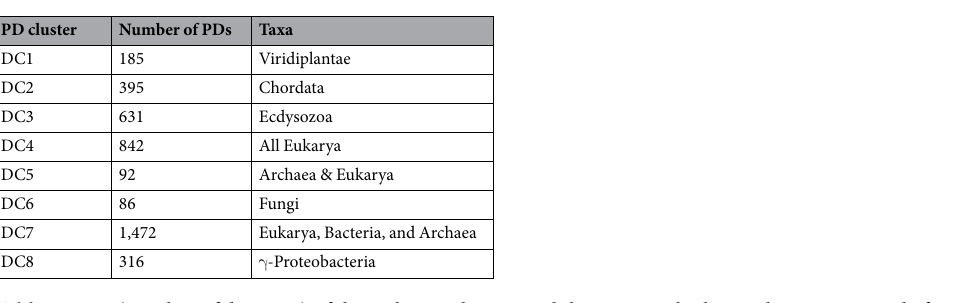
Table 1. Size (number of domains) of the eight PD clusters and the taxa in which members were mainly